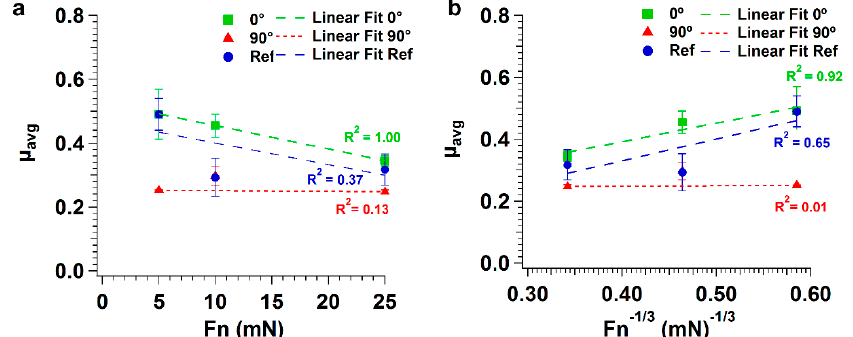
Figure 4. Variation of the average friction coefficient with ( a ) applied load and ( b ) with the applied load to the power ( − 1/3), for polished (Ref = reference sample) and textured specimens, in the parallel (0°) and perpendicular (90°) sliding directions.